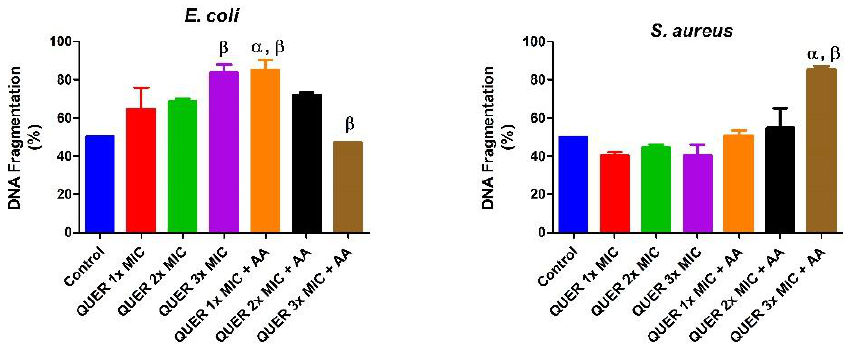
Figure 6. DNA fragmentation in bacterial isolates following exposure to quercetin (QUER) alone or when combined with ascorbic acid (AA). Results are presented as an average of duplicate biological experiments (n = 2) with the corresponding standard error of the mean (SEM). Relative to the control or QUER 1 × MIC, α at p < 0.05 is significant, as is β at p < 0.01 when compared with the control or QUER 3 × MIC.